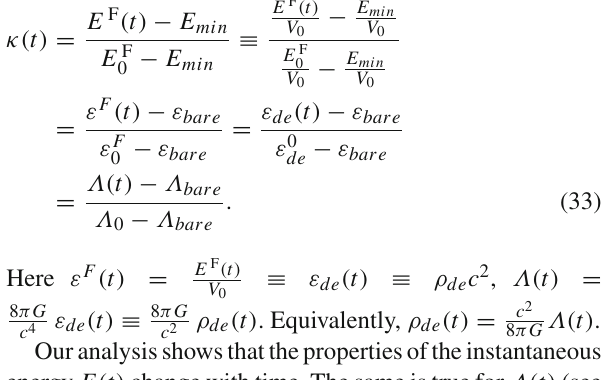
) is the volume of the considered sys- 0